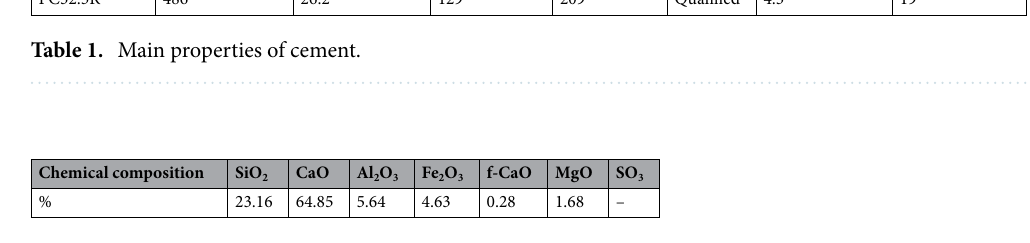
Table 2. Chemical composition of cement.